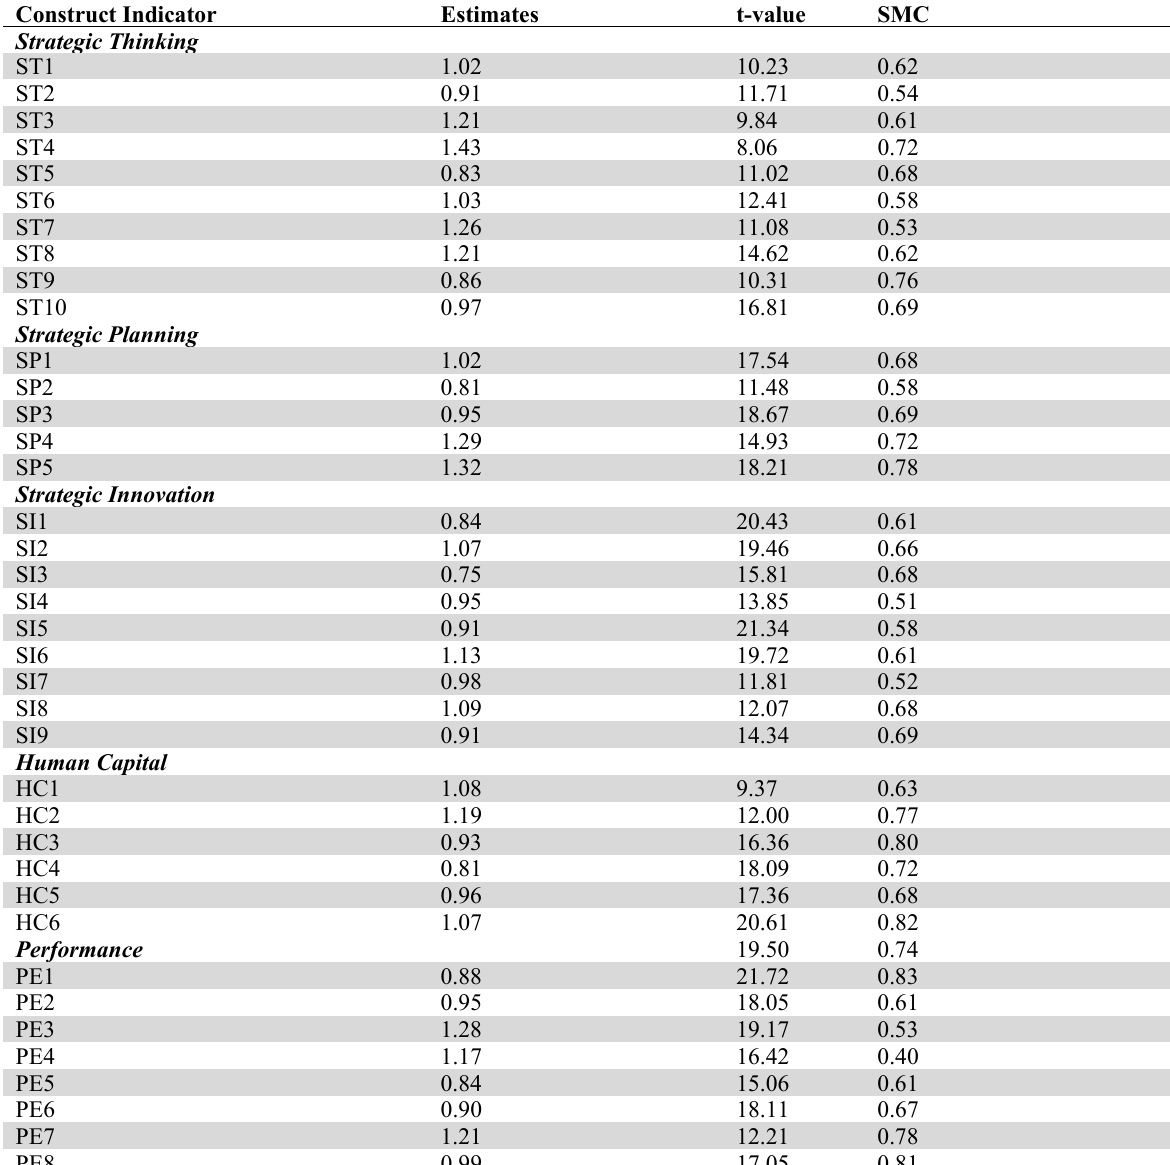
The results of confirmatory factor